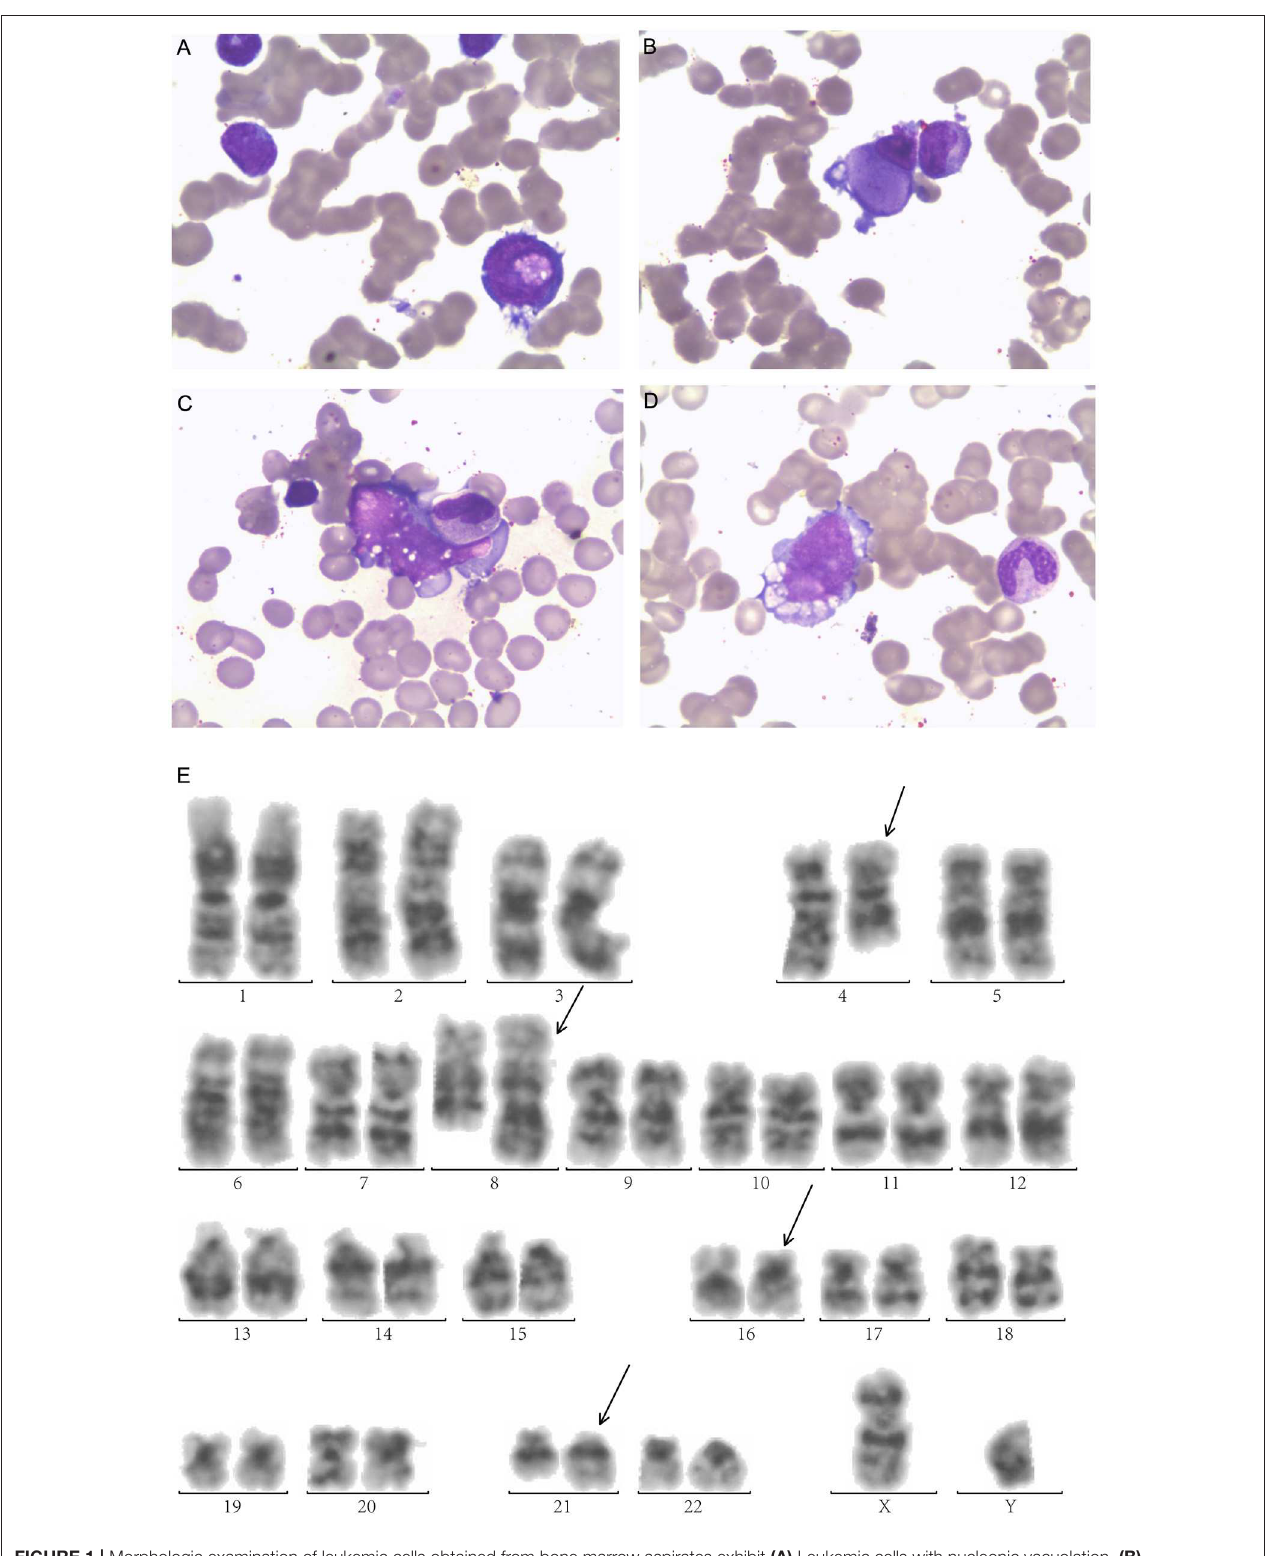
FIGURE 1 | Morphologic examination of leukemic cells obtained from bone marrow aspirates exhibit (A) Leukemic cells with nucleonic vacuolation. (B) Megakaryocyte dysplasia (C) hemophagocytosis (D) cytoplasmic vacuolation. (E) G-banded bone marrow karyogram showing 46,XY,t(4;8)(q28;q24.1), t(16;21)(p11.2;q22). Black arrows indicate abnormal karyotypes.